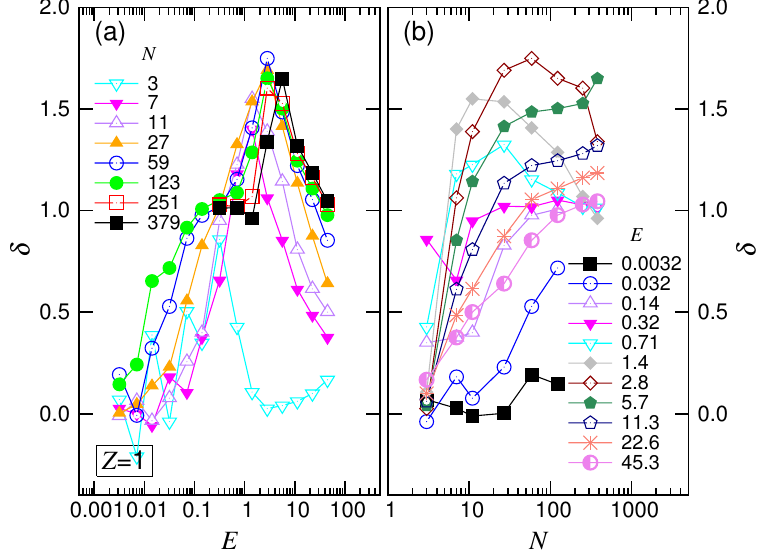
Figure 6. Exponent δ ( a ) as a function of E at different N and ( b ) as a function of N for different E , in the monovalent salt solution. The values of E in the plots are the geometric means of the pairs of the adjacent driving field strengths given in the legend of Figure